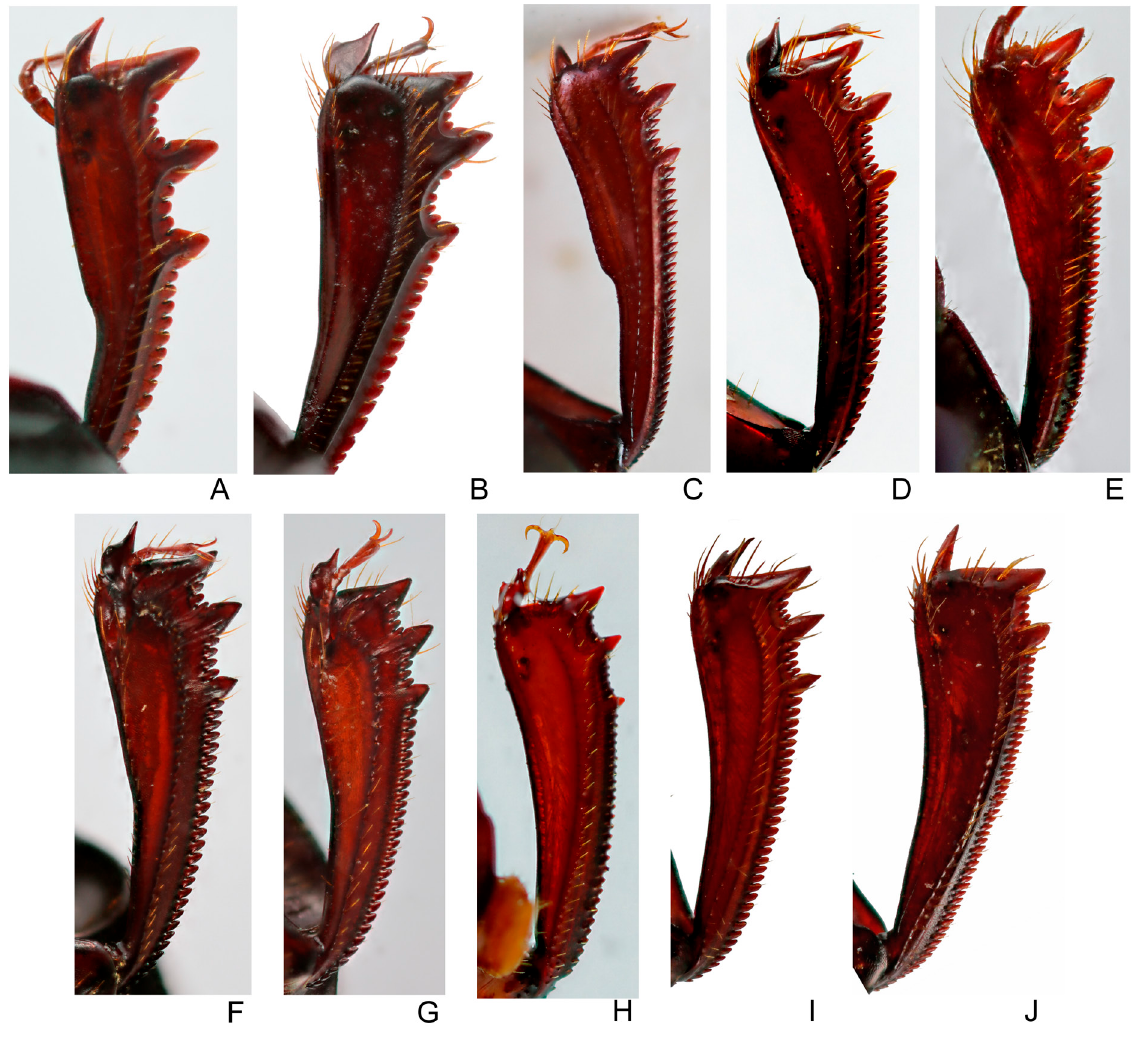
Fig. 11. Morphological diversity in the protibiae of Sylvicanthon Halffter & Martínez,